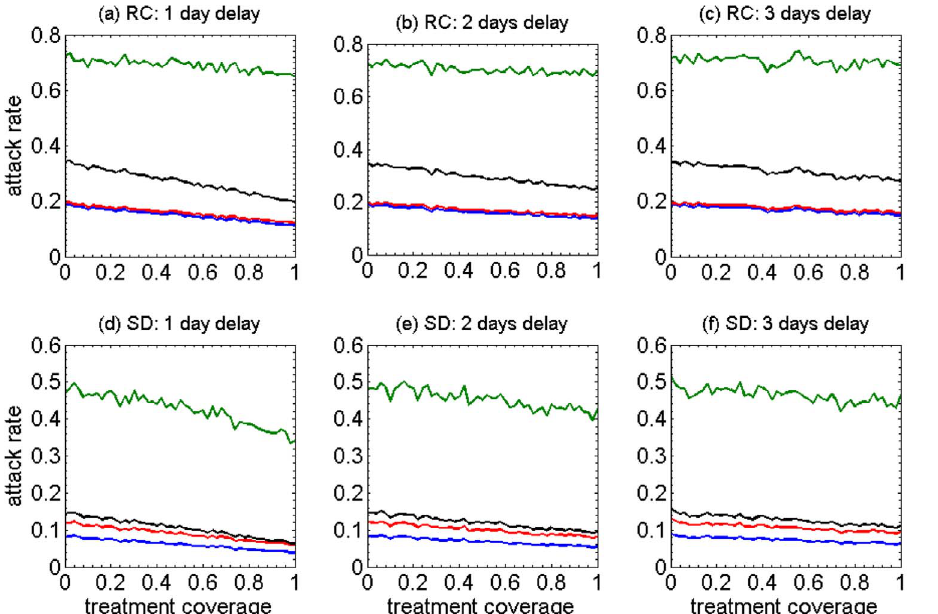
Figure 2. The impact of different coverages (0–100%) of antiviral treatment on the age-specific relative attack rates under different assumptions for the mean time between symptoms onset and the start of treatment (1–3 day delay). Panels a–c (RC) show results from the model representing the remote and isolated Canadian Aboriginal community, and panels d–f (SD) show results from the model representing a community with an urban-like shifted demographic structure. Green: School-aged children (6–18); red: adults (19–49); blue: older adults (50 + ); black: pre-school (0–5).